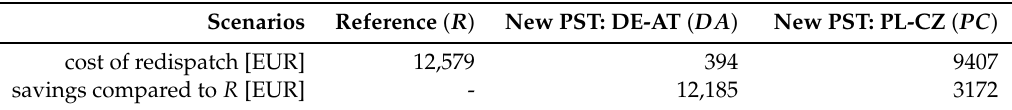
Table 1. Costs of remedial actions and savings as compared to their reference